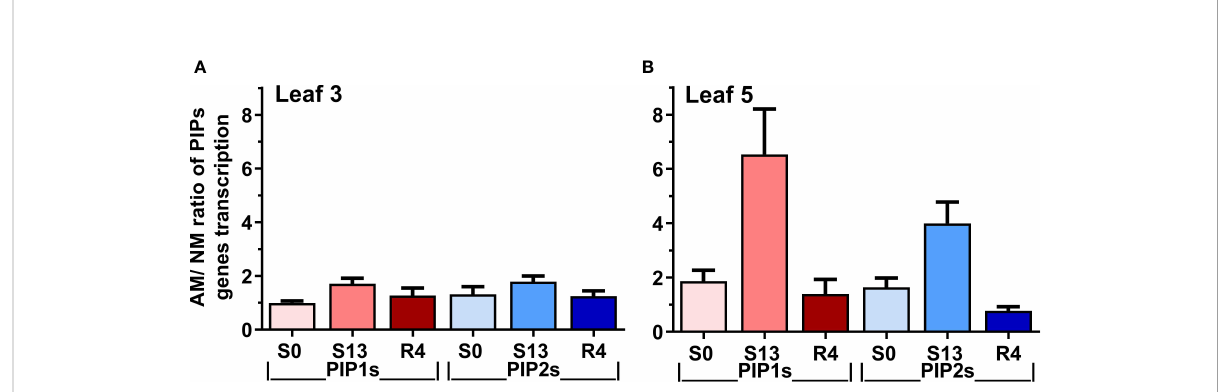
FIGURE 7 Expression ratio of mycorrhized (AM) to non-mycorrhized (NM) plants for PIP1 or PIP2 genes at (A) upper (leaf 3) or (B) middle (leaf 5) shoot levels. The indexes were calculated for optimal irrigation (S0), the maximum drought (S13) and rehydration (R4) by dividing the total accumulation of aquaporin transcripts of PIP1 or PIP2 aquaporins. Bars represent mean values and standard error of mean. The calculations are based on mean values of AM and NM plants, taken from Figures 5, 6.